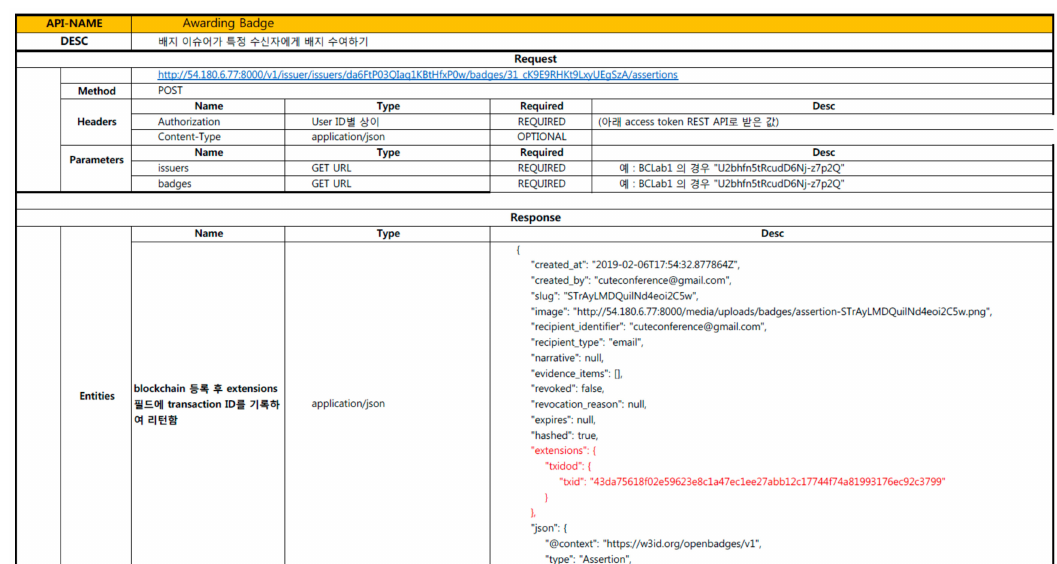
Figure 17. REST API for awarding